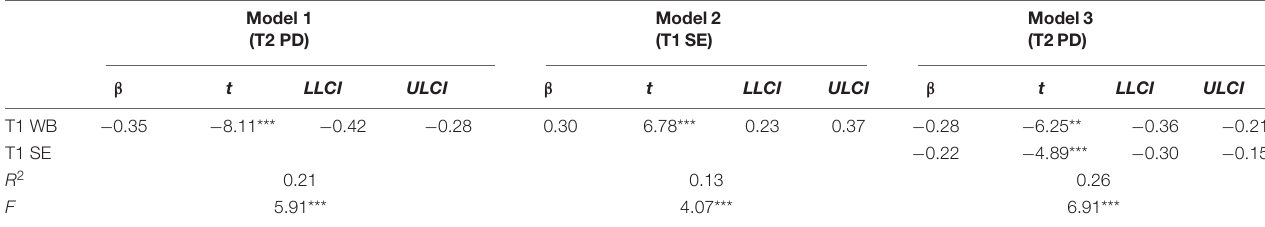
TABLE 2 | Testing the mediating effect of self-esteem (T1) on perceived discrimination (T2).